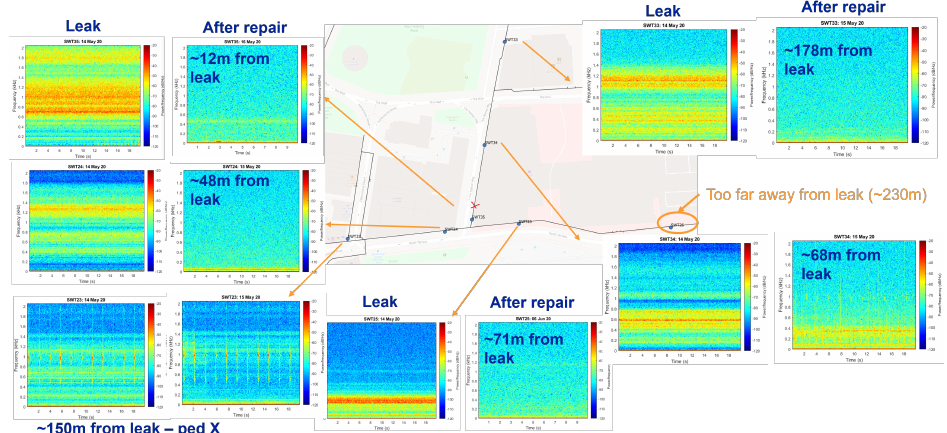
Figure 5. An illustration of a single leak source originating from a broken back pipe, and the noise spectrograms picked up by 6 HWM PermaNET+ loggers in the vicinity. The 7th sensor on the right is located too far away to pick it up.